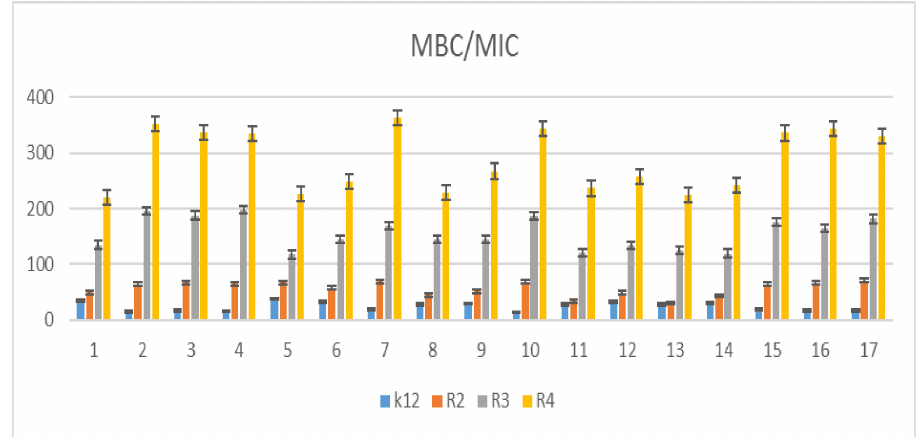
Figure 5. MBC/MIC of the coumarin derivatives in model bacterial strains. On the x -axis, com- pounds 1 – 17 are used sequentially. The y -axis shows the MBC/MIC value in µ g/mL − 1 (see Supplementary